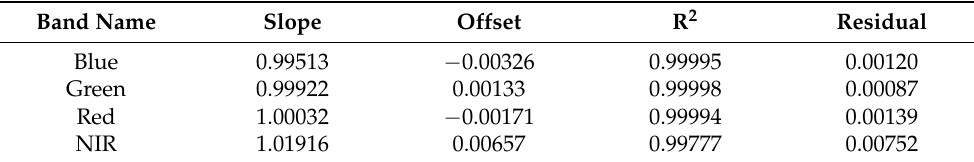
Table 6. Coefficients of the linear regression bandpass adjustment (OLI = slope * GF2+ offset) and the mean residual.